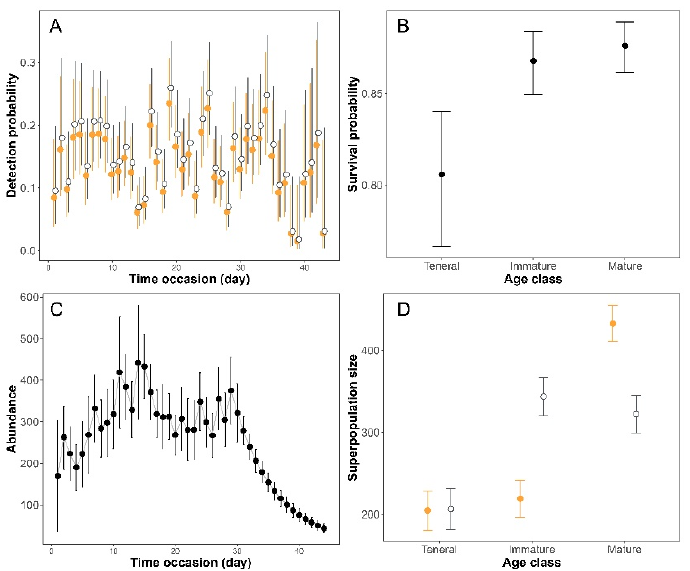
Figure 2. Predictions of the Cormack–Jolly–Seber model and POPAN model for capture–mark–recapture of Platycnemis subdilatata in northeastern Algeria. ( A ) Detection probability of males (grey open circle) and females (orange solid circle) across time occasion. ( B ) Survival probability of teneral, immature, and mature individuals. ( C ) Seasonal pattern of abundance estimated with the POPAN model. ( D ) “Superpopulation” size for teneral, immature, and mature individuals (males are in grey open circle and females are in orange solid circle).